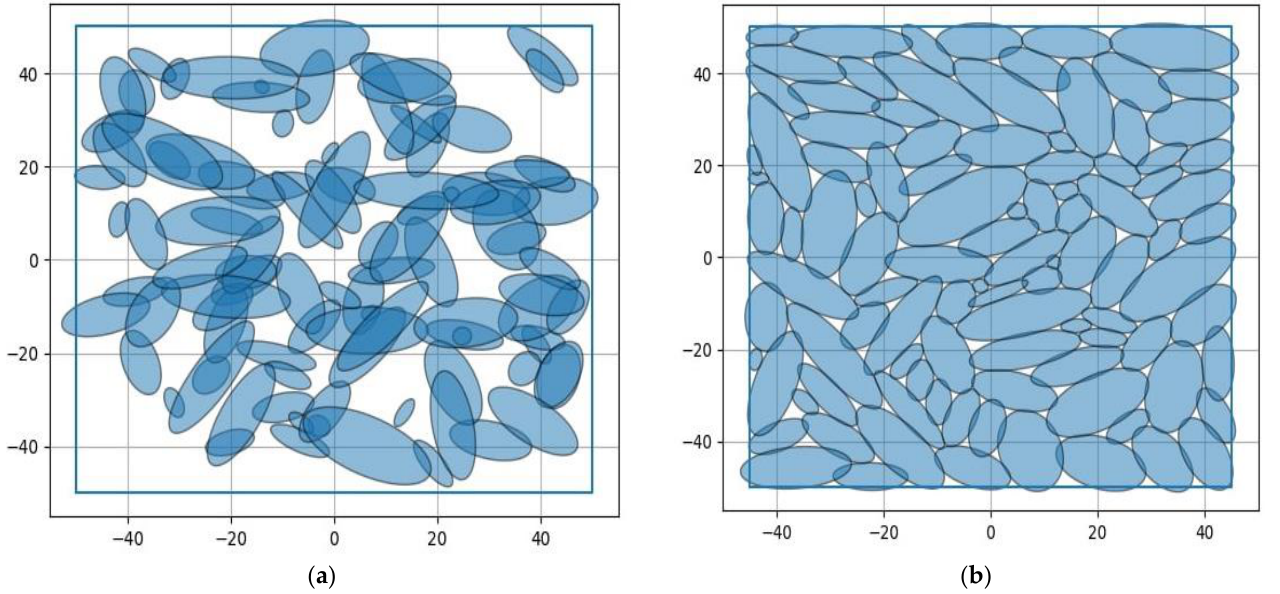
Figure 7. The continuous MCLP of 100 ellipses: ( a ) starting point and ( b ) local optimum.